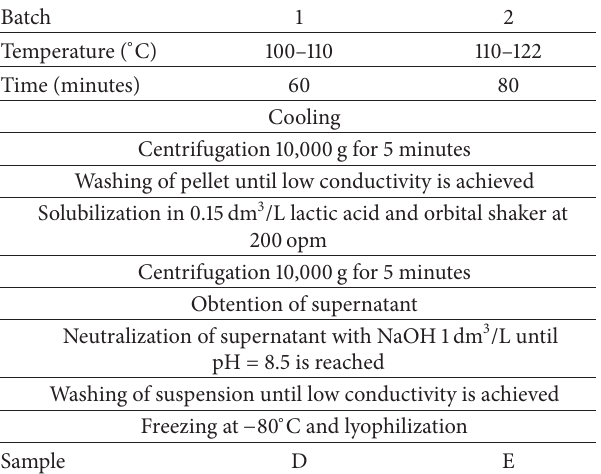
Table 3: Conditions of alkaline deacetylation of chitin and purifica- tion of chitosan